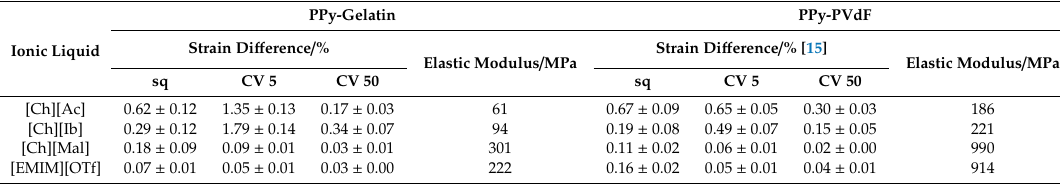
Table 3. Strain di ff erence (%) calculated according to (1). sq—actuators driven with square Table 3. Strain difference (%) calculated according to (1). sq—actuators driven with square wave